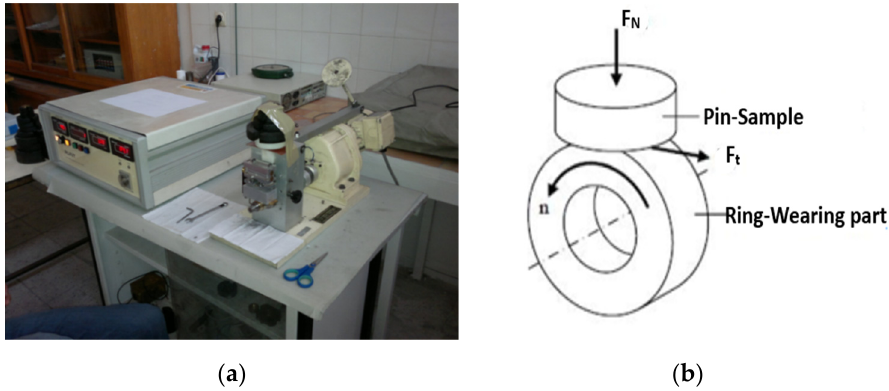
Figure 2. ( a ) The pin-on-ring test device used in the wear test, ( b ) Pin, ring contact geometry and